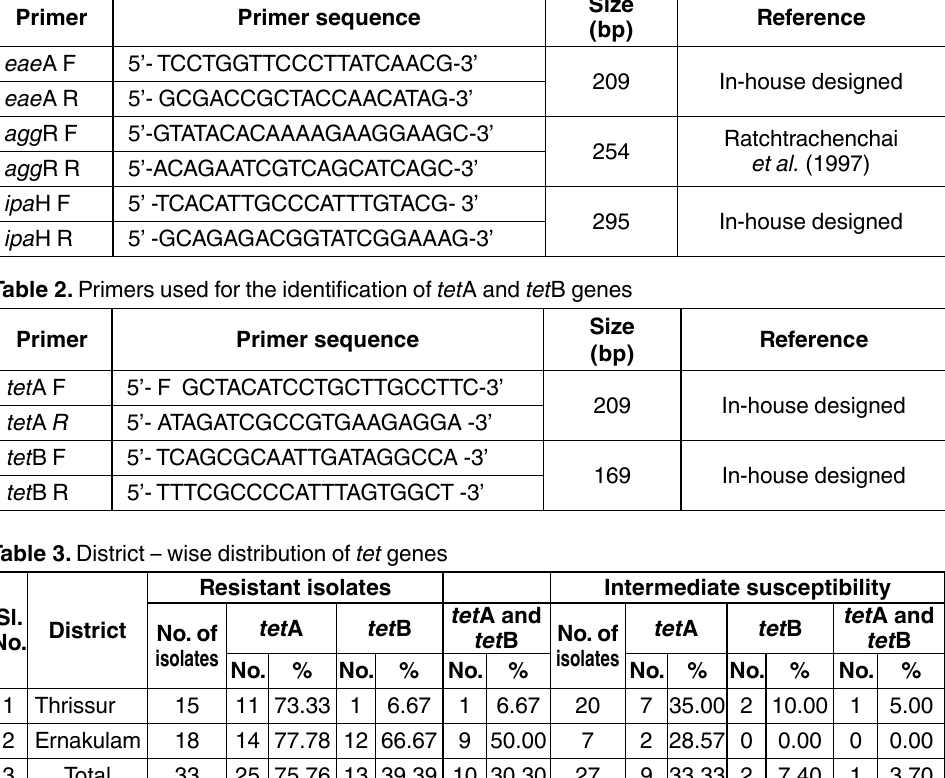
table 1. Primers used for the virulence genes of E. coli Primer